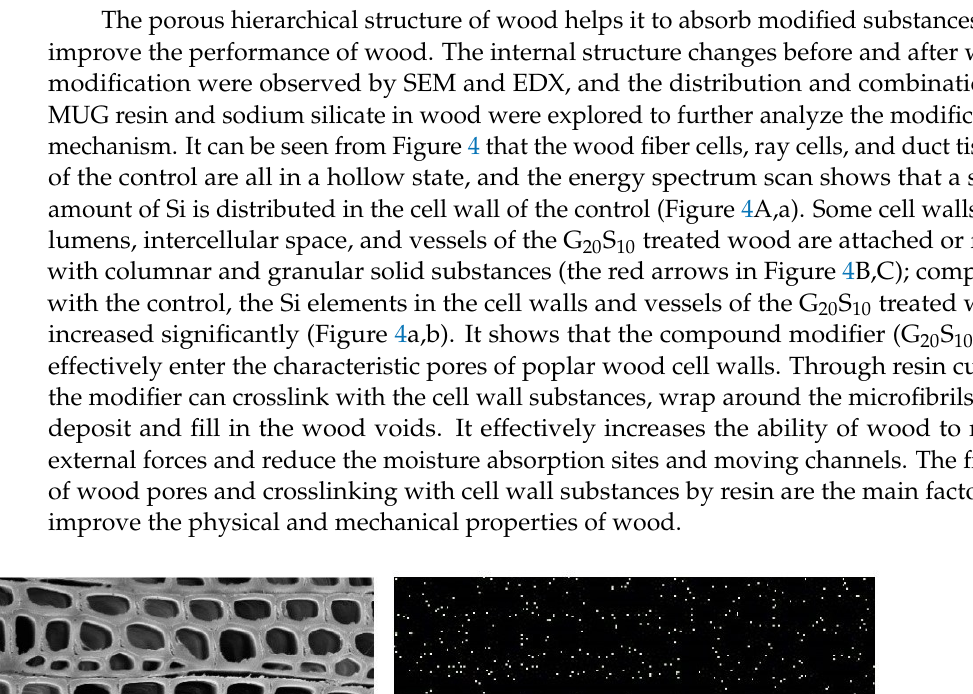
Table 3. Mechanical properties of the modified wood.